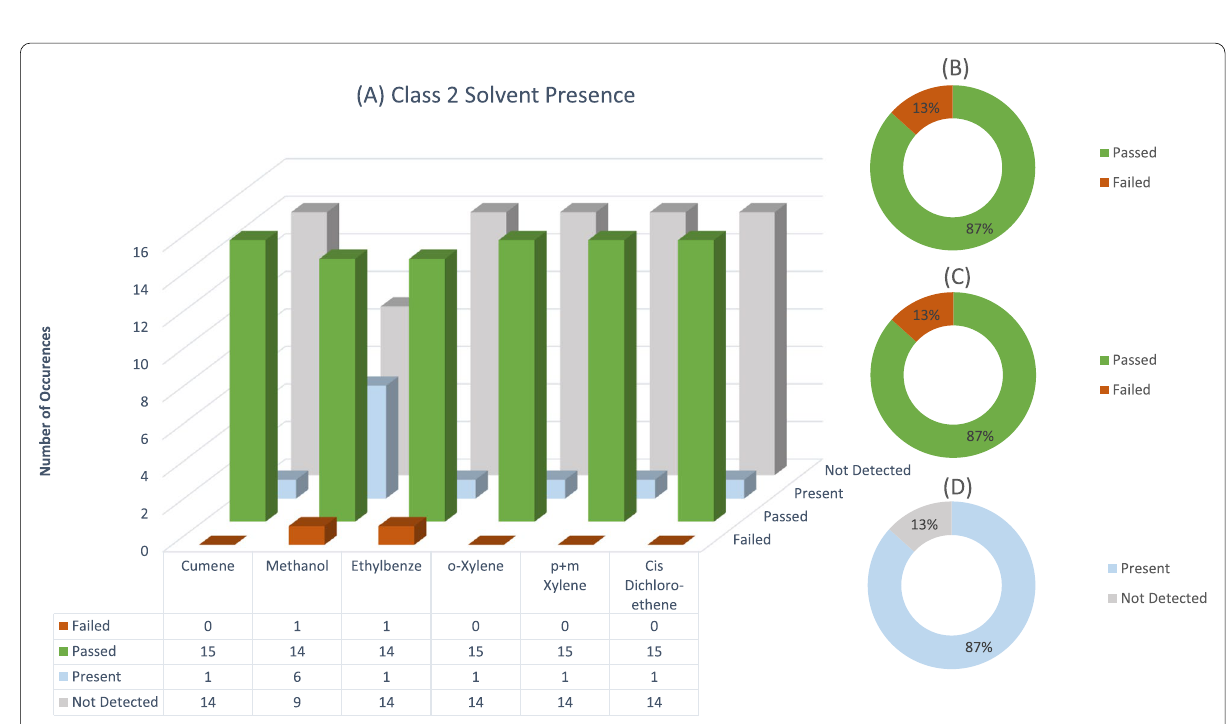
Fig. 3 Number of Individual solvent failure occurrences, and the number of times a class 2 solvent was present ( A ). Total percentage of sample failures for class 2 solvents, if all solvents present in a sample are summed ( B ). Total number of sample failures for all class 2 solvents where one solvent exceeded the limit ( C ). Total percentage of samples for class 2 solvents where any solvent was detected in sample ( D